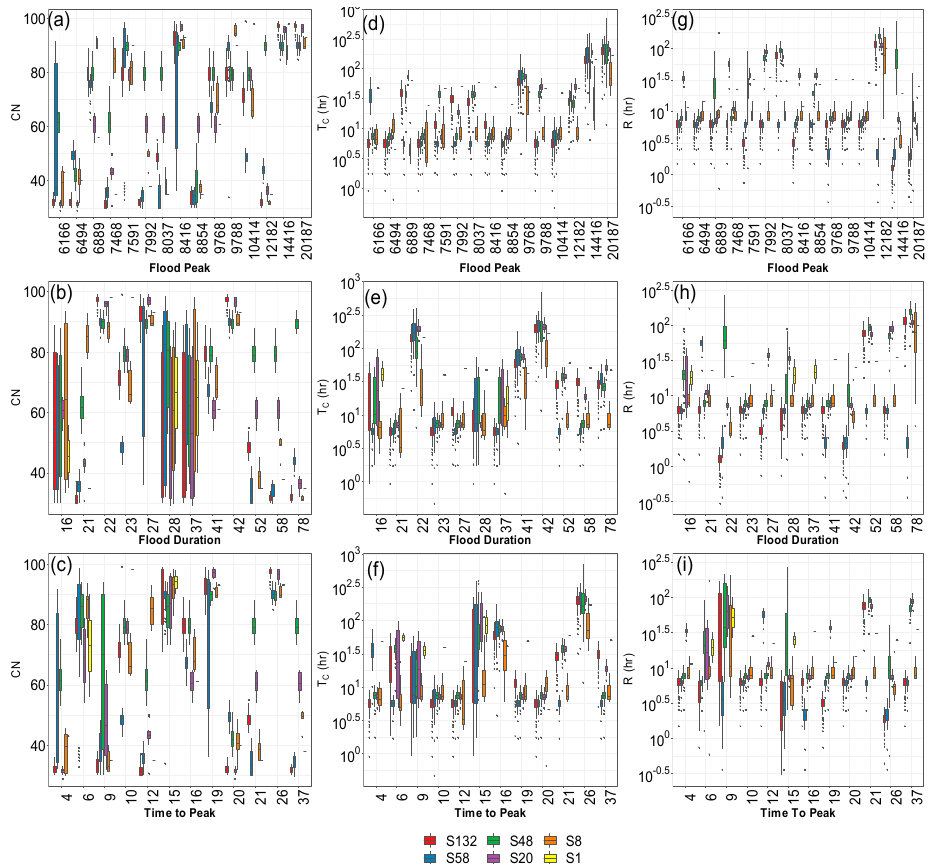
Figure 7. Boxplots of calibrated parameter values of all sub-basins of six configurations with respect to flood events’ characteristics. Three columns, left to right, ( a – c ) corresponds to CN, ( d – f ) correspond to T c and ( g – i ) correspond to R, respectively. The rows from top to bottom correspond to flood peak, flood duration and time to peak, respectively. Boxplots of red, blue, green, purple, orange and yellow colors correspond to S132-, S58- S48-, S20-, S8-and S1- configurations, respectively.